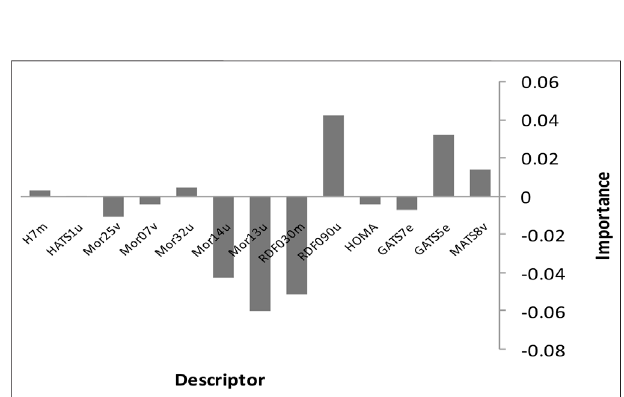
FIGURE 8 | Relative mean effects for SPA-MLR